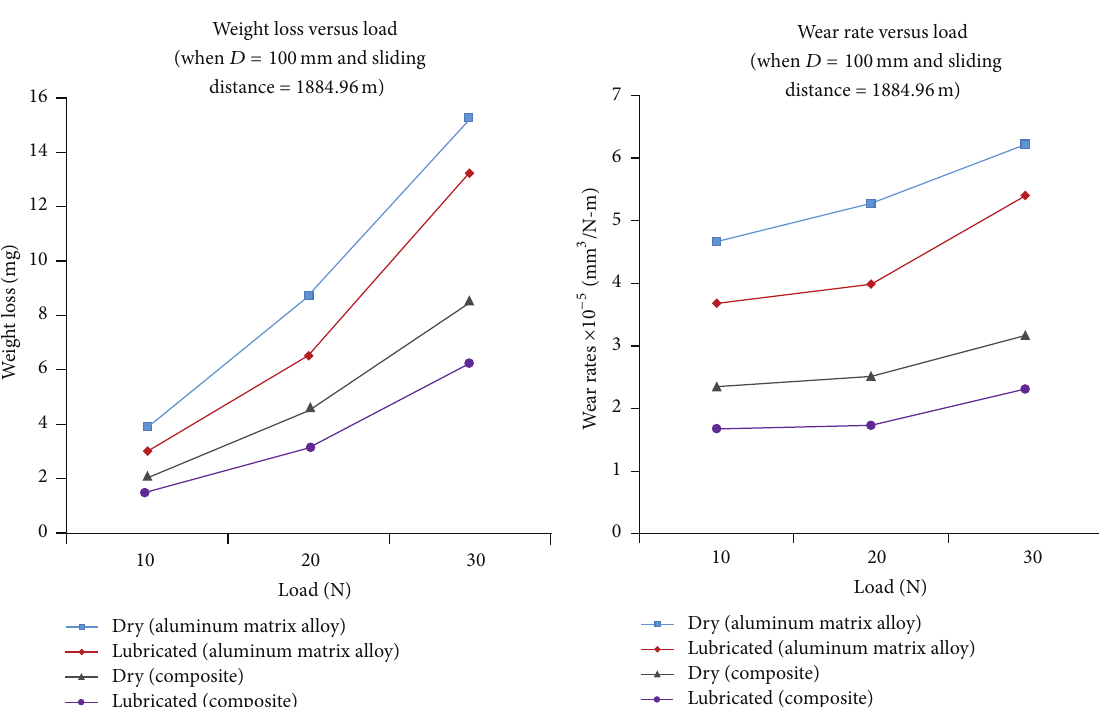
Figure 4: Variation of weight loss and wear rates at sliding distance 1884.96 m with increasing loads.